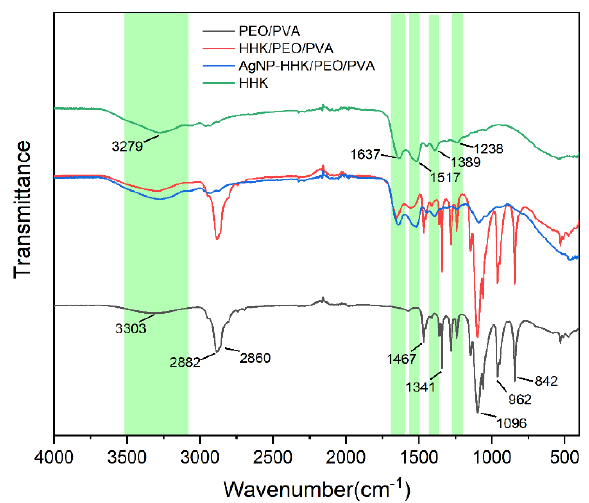
Figure 5. FTIR spectra of the PEO/PVA, HHK/PEO/PVA and AgNP-HHK/PEO/PVA nanofibrous mats. brous